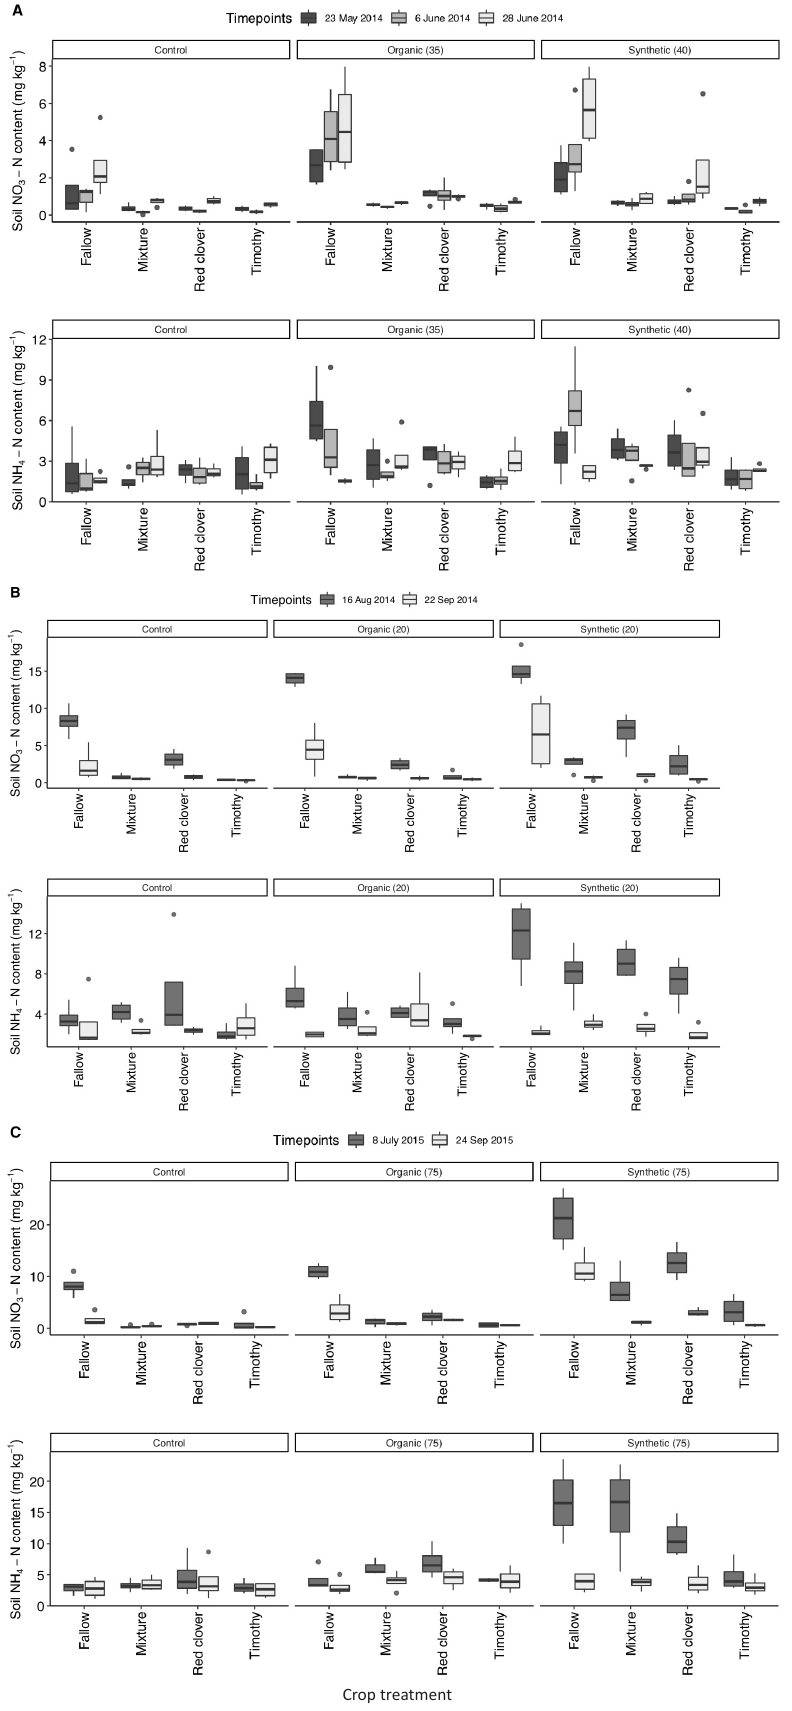
Fig. 3. Box plots (n=4) of soil nitrogen pool dynamic change during the first period (A), second period (B), and third period (C) regarding fertilizer-crop interaction. The fertilizer application rates (kg N ha -1 ) were indicated in brackets. The individual points are the data points outside of 1.5 times of the inter- quantile